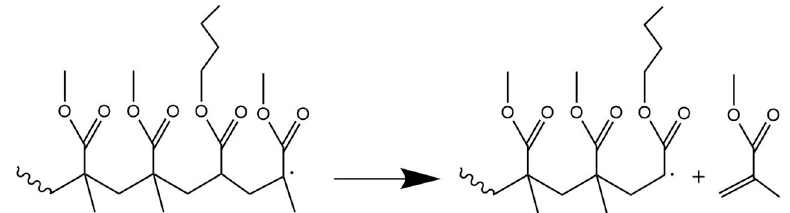
Figure 17. So-called blocking mechanism for unzipping ( β -scission) in case n-butyl acrylate units are present in the MMA-rich backbone. The secondary radical is less stable than then typical tertiary radical so that this specific β -scission is less likely to